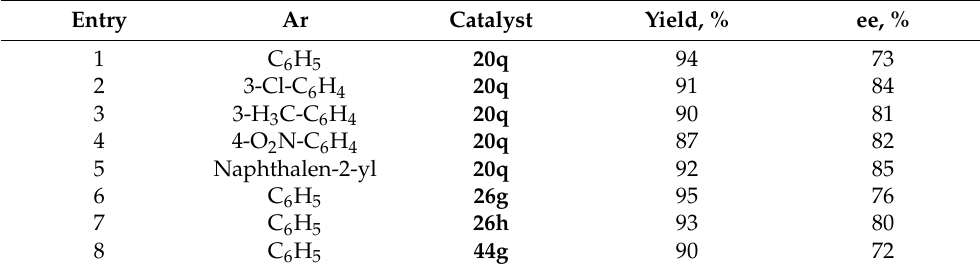
methylphenyl 72 : 81% ee; 4-nitrophenyl 72 : 82% ee) (Table 10, entries 2–4), while ortho - substituted 72 derivatives were obtained as almost racemic